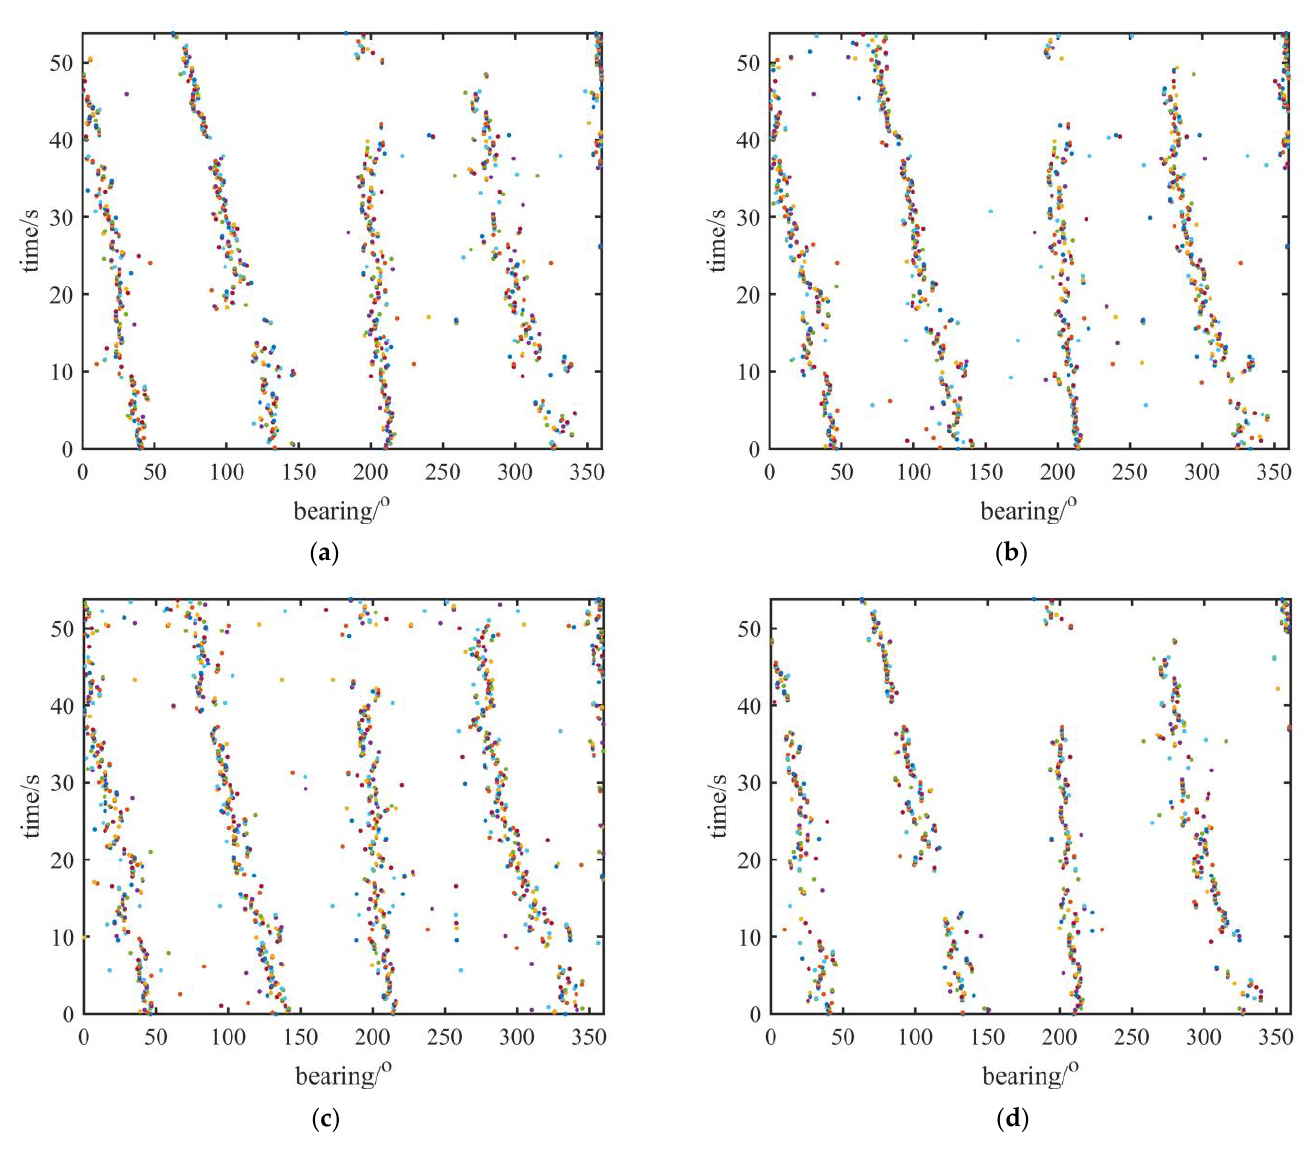
Figure 5. Traces of boats estimated by multimodal fusion algorithm: ( a ) traces of boats employing two modes, including original signal and mode 1; ( b ) traces of boats employing three modes, including original signal, mode 1, and mode 2; ( c ) traces of boats employing four modes, including original signal, mode 1, mode 2, and mode 3; ( d ) traces of boats obtained without using multimodal fusion.